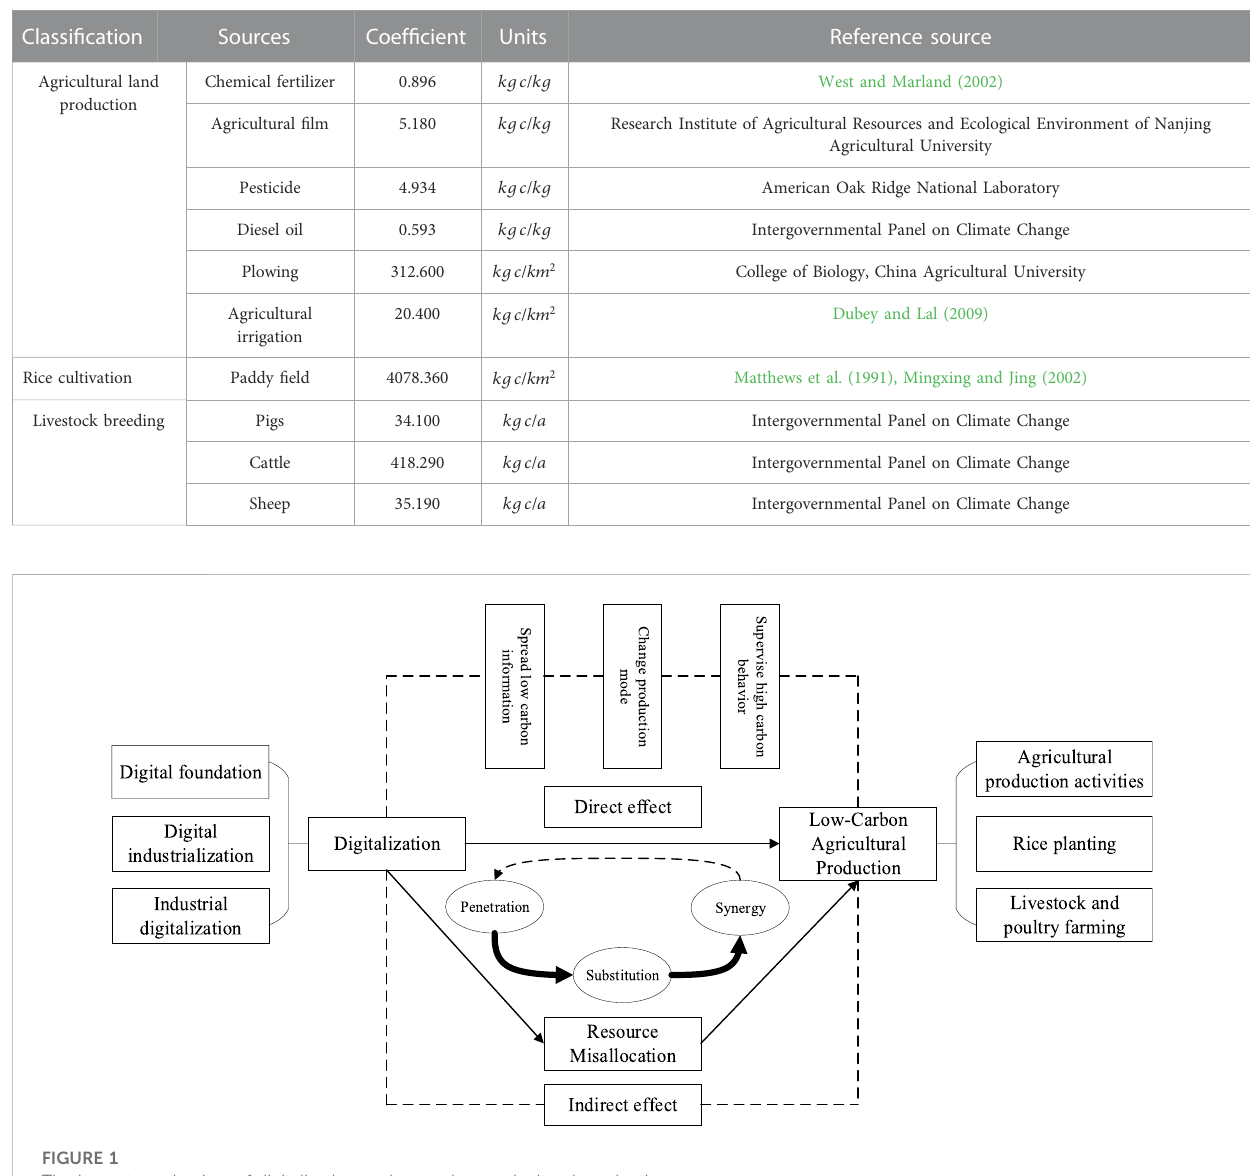
TABLE 1 The carbon sources and its carbon emissions coef fi cient.